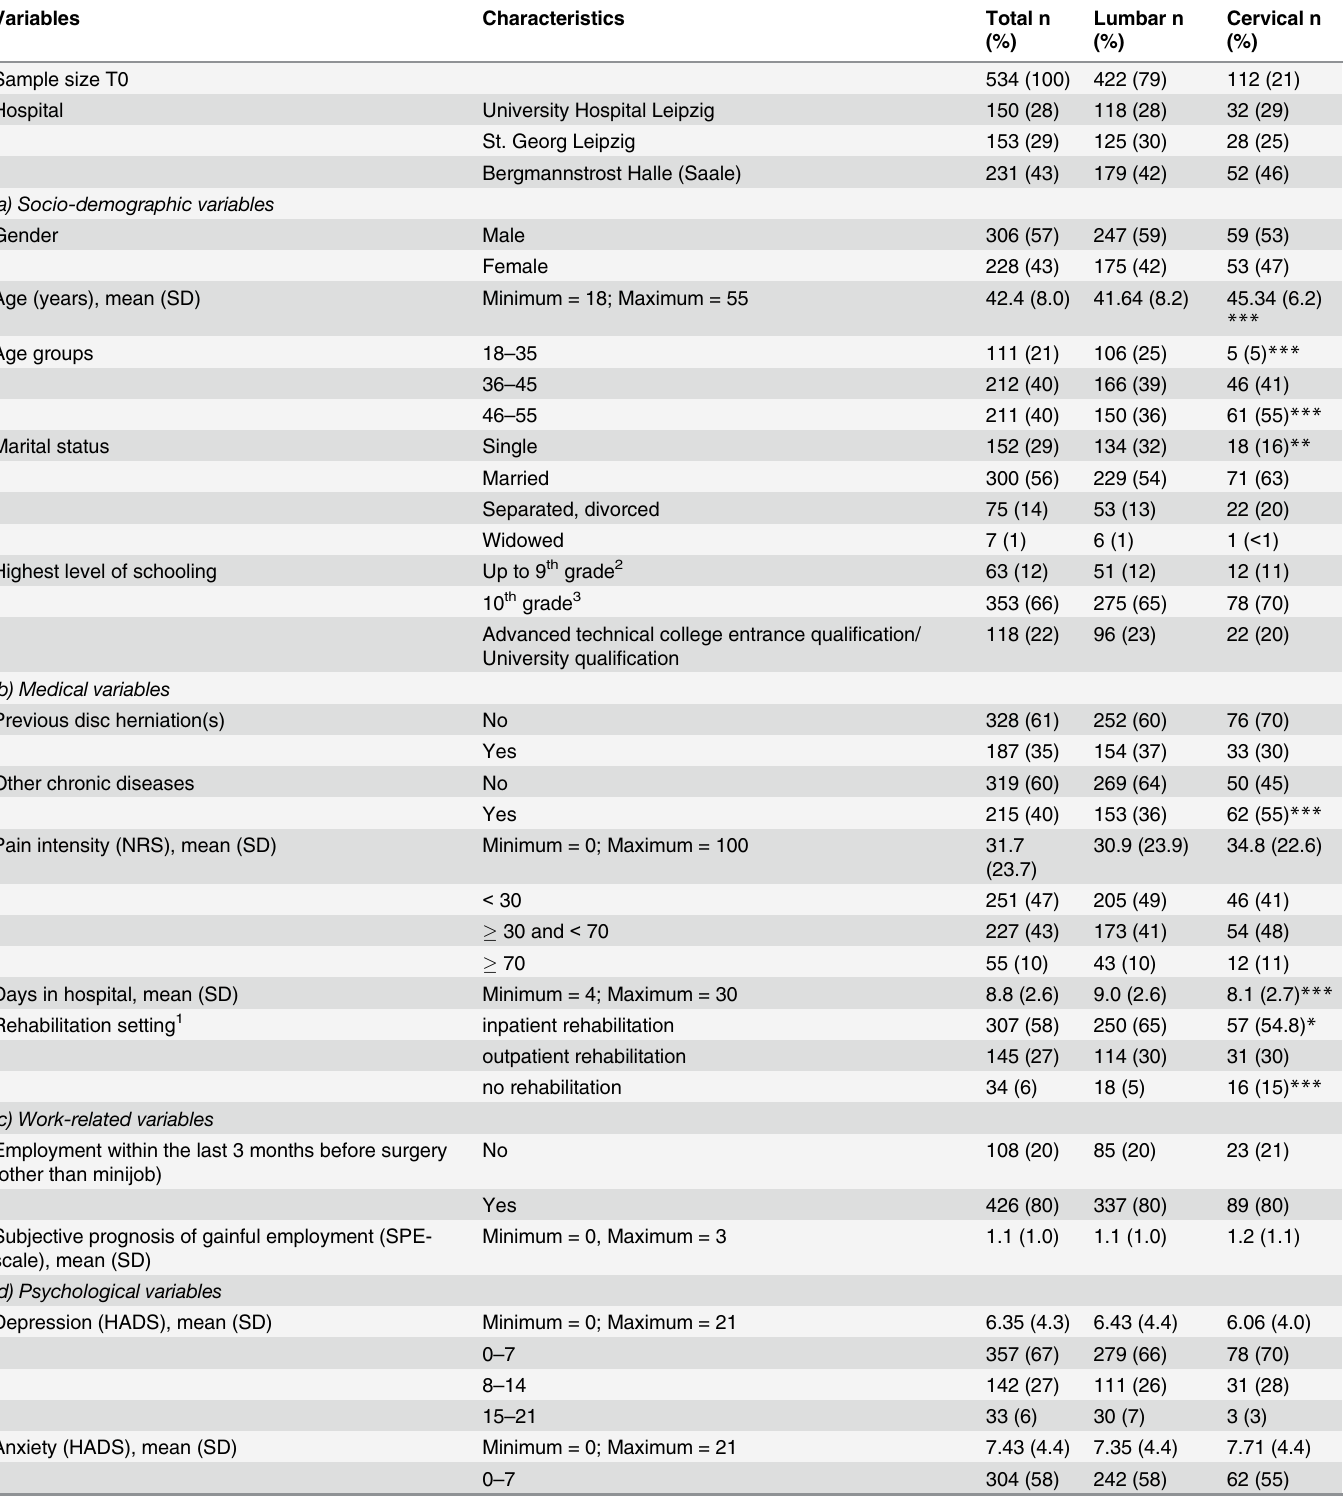
Table 1. Sample characteristics at